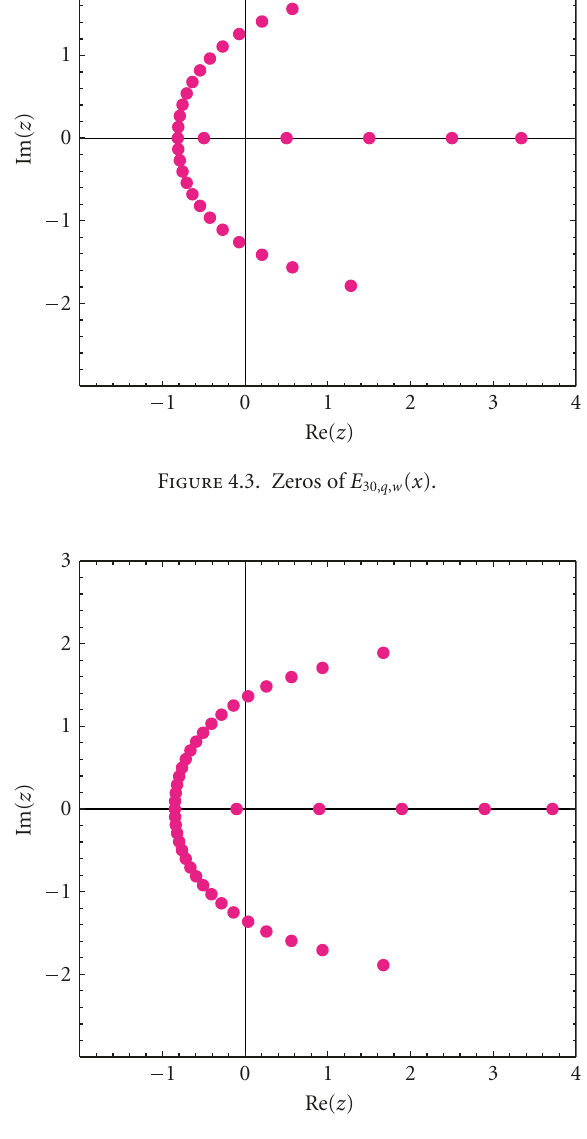
Figure 4.4 . Zeros of E 40, q , w ( x